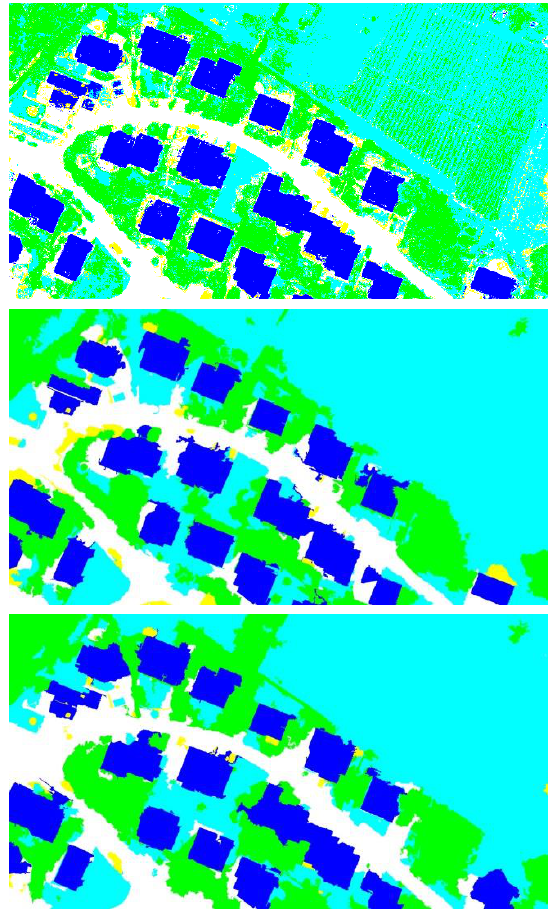
Figure 6. Pixel-based map (top), ESP object-based map (middle) and object-based map of proposed method (bottom) Table 3. Evaluation on land cover maps obtained from pixel- based classification, object-based classification on ESP